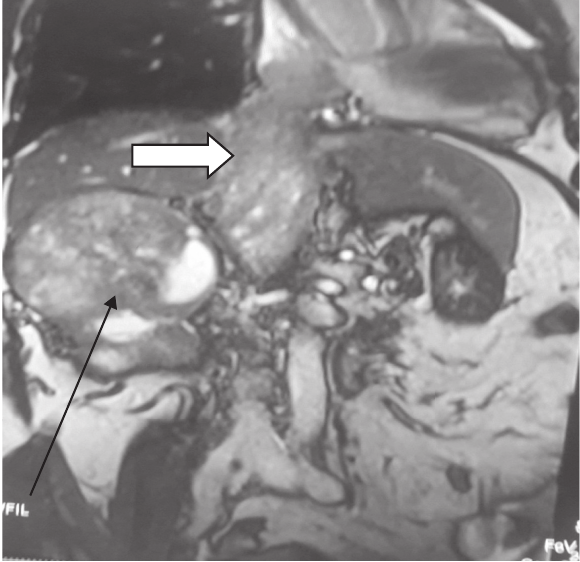
Figure 3: Level 4 thrombus with arrow (Black) showing mass in right kidney and white arrow thrombus in IVC extending to right atrium.